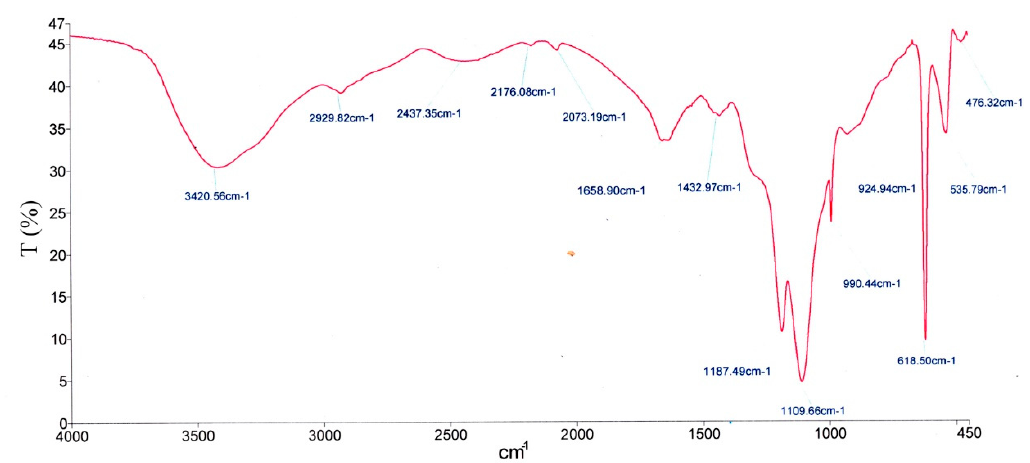
Figure 8. Fourier-transform infrared spectroscopy.